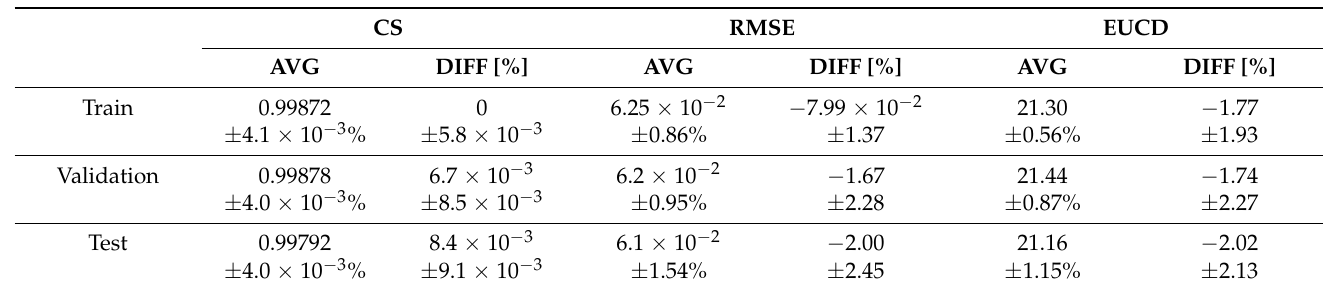
Table 6. Statistical comparison between ConvLSTM-SA model and model without self-attention layer.